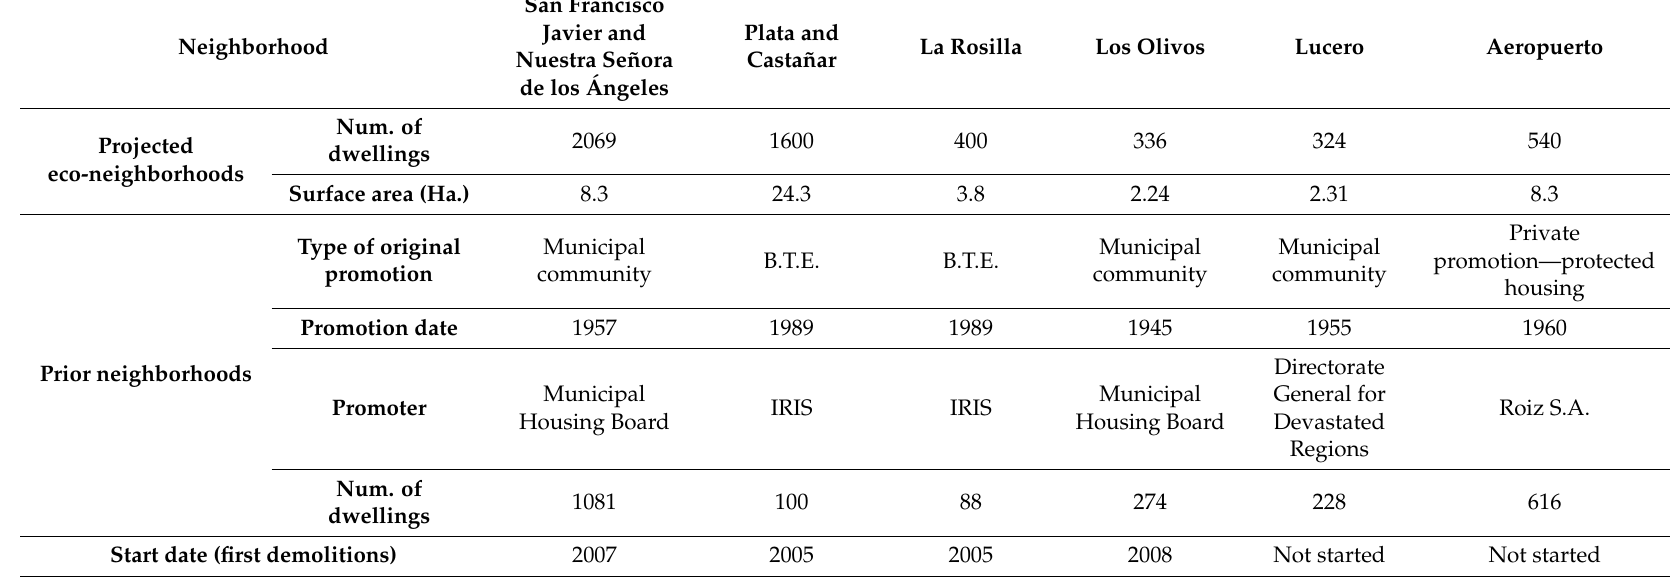
Table 1. Eco-neighborhood projects in Madrid. (B.T.E.: Neighborhoods of Special Typology; neighborhoods of prefabricated houses built outside of urban environments for the Roma population). Source: The authors based on information published in the media and Madrid City Council data (Urban Planning Geographic Data, Madrid City